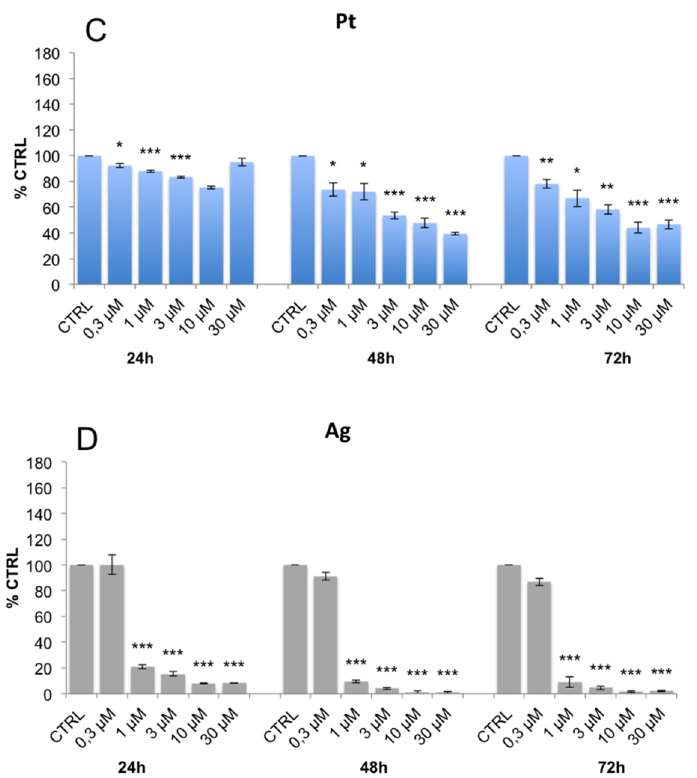
Figure 3. Cell viability assay on SH-SY5Ycells upon HFt-based nanocarriers exposure: ( A ): HFt; ( B ): HFt-Au; ( C ): HFt-cisPt and ( D ): HFt-Ag. For each type of nanocarrier, 24 h, 48 h and 72 h treatments with six different amounts of nanocarriers were assayed. Each series is formed by the following amounts of nanocarriers (expressed as metal concentration): control = no NCs; 0.3 µ M; 1.0 µ M; 3 µ M; 10 µ M; 30 µ M. For each experimental condition, viability percentage with respect to control is shown. Each point represents the mean value of three different experiments, each of which is based on eight different points. Standard errors are indicated. Statistical significance assessed by * p ( t -test) < 0.05; ** p ( t -test) < 0.01; *** p ( t -test) <